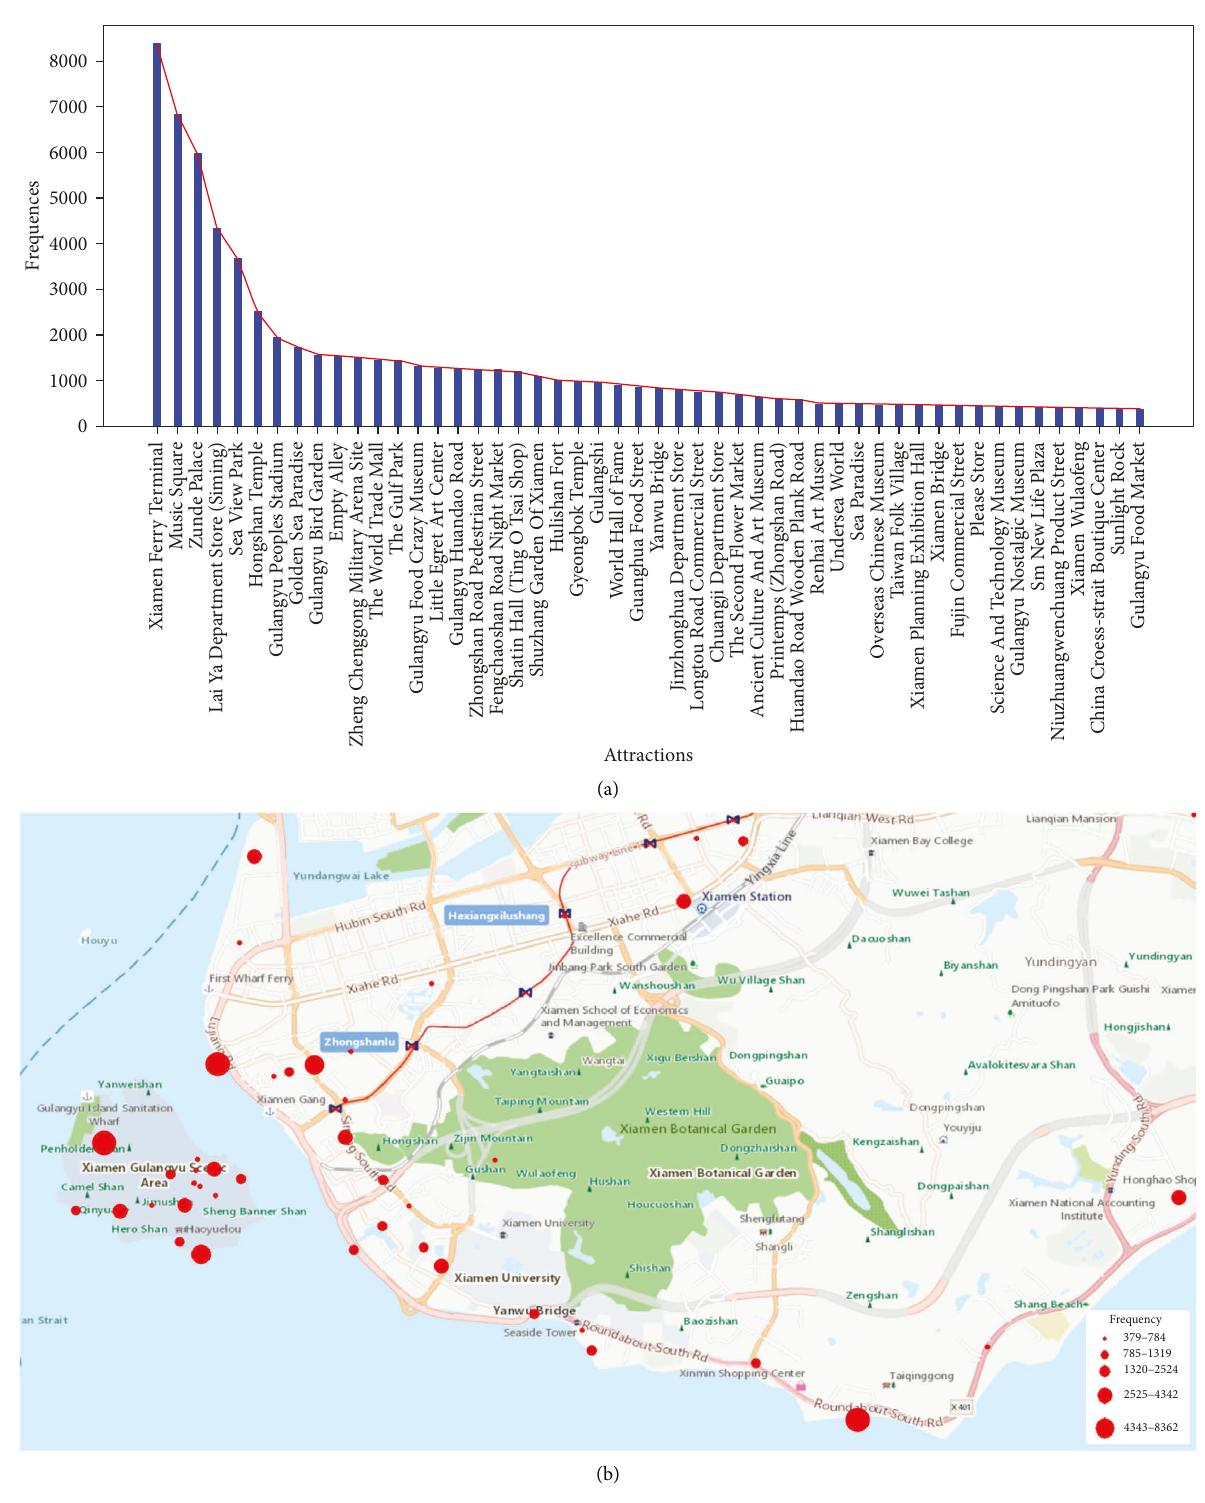
Figure 4: Popular tourism attractions in Xiamen. (a) Top 50 popular attractions. (b) Top 50 popular attractions on the city